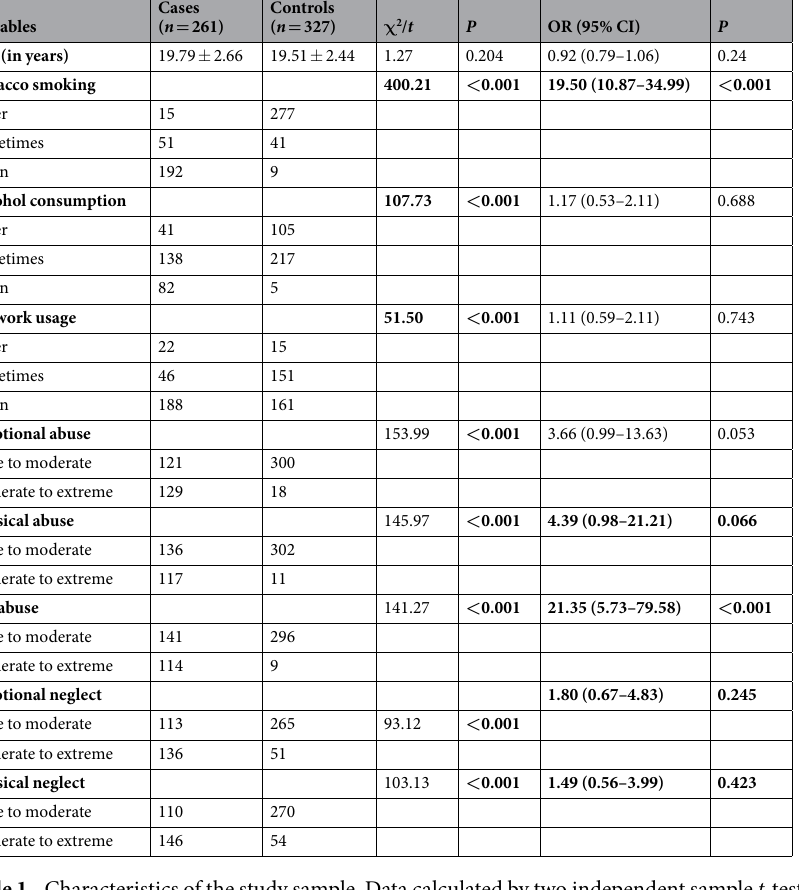
Table 1. Characteristics of the study sample. Data calculated by two independent sample t- tests and logistic regression and other variables were controlled. Positive results are in bold. Variable may not add up to the total number due to missing values.